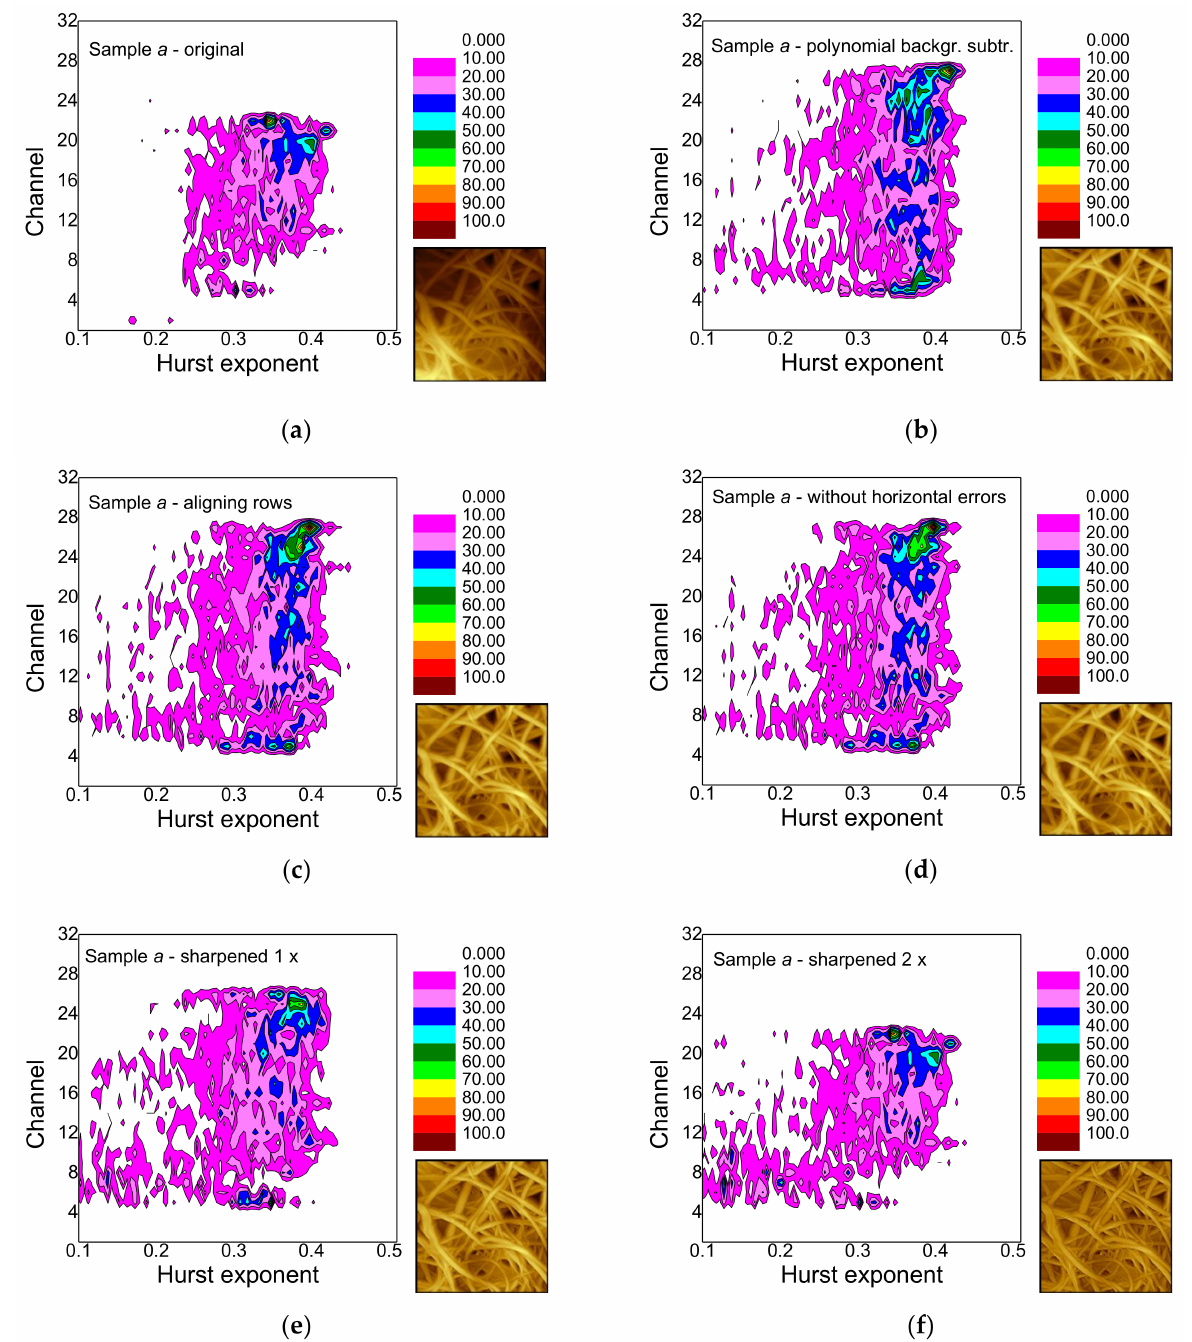
Figure 6. Gray-scale-resolved Hurst exponent distribution of sample a : ( a ) original (identical to Figure 5a); ( b ) after polynomial background subtraction; ( c ) after aligning rows; ( d ) after deleting horizontal errors; ( e ) after sharpening; ( f ) after sharpening